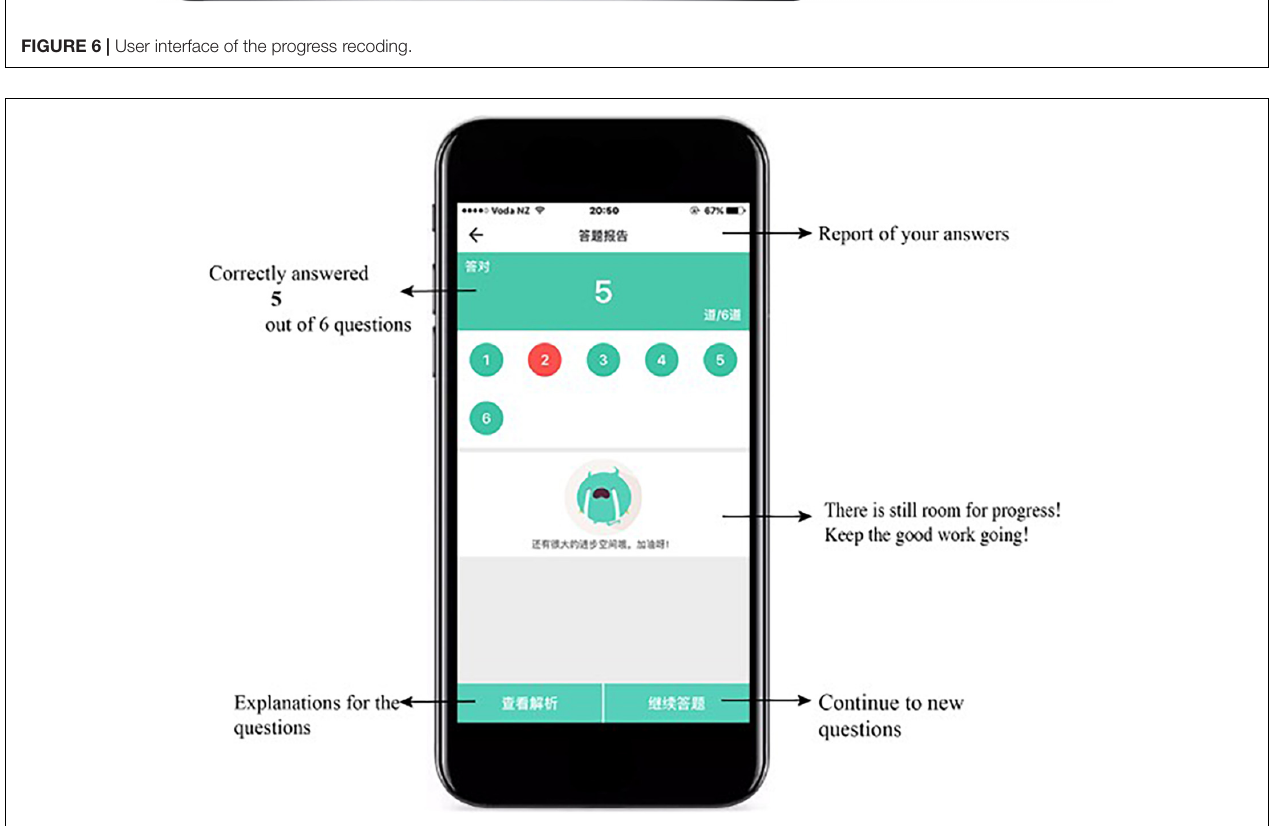
FIGURE 7 | User interface of the